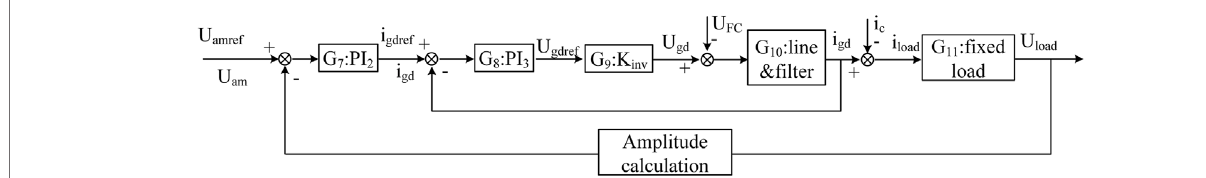
FIGURE 5 | Transfer diagram of the line-side converter.